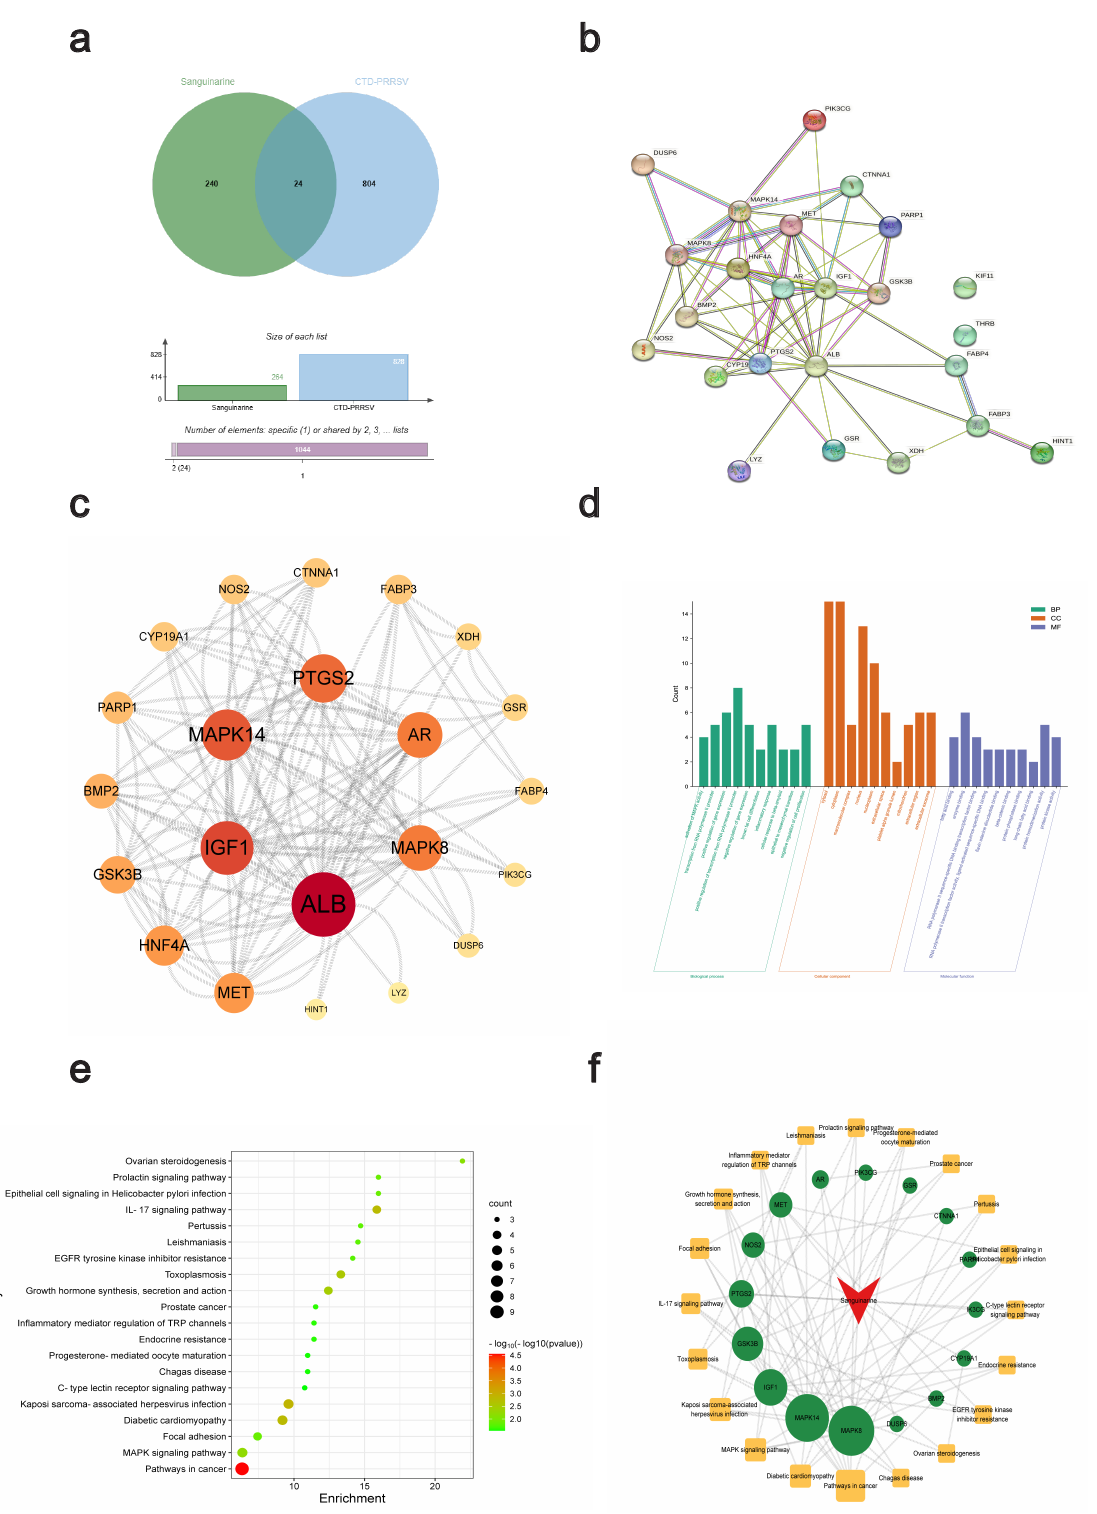
Figure 5. Screening of potential anti-PRRSV targets of sanguinarine through network pharmacology. ( a ) Intersection of sanguinarine targets and PRRS targets. ( b ) PPI network of the targets obtained in ( a ). ( c ) Topological analysis of the PPI network in ( b ). ( d , e ) Top 10 GO enrichment results ( d ) and top 20 KEGG pathways ( e ) of the targets obtained in ( a ). ( f ) Topological analysis of the network of the sanguinarine-core